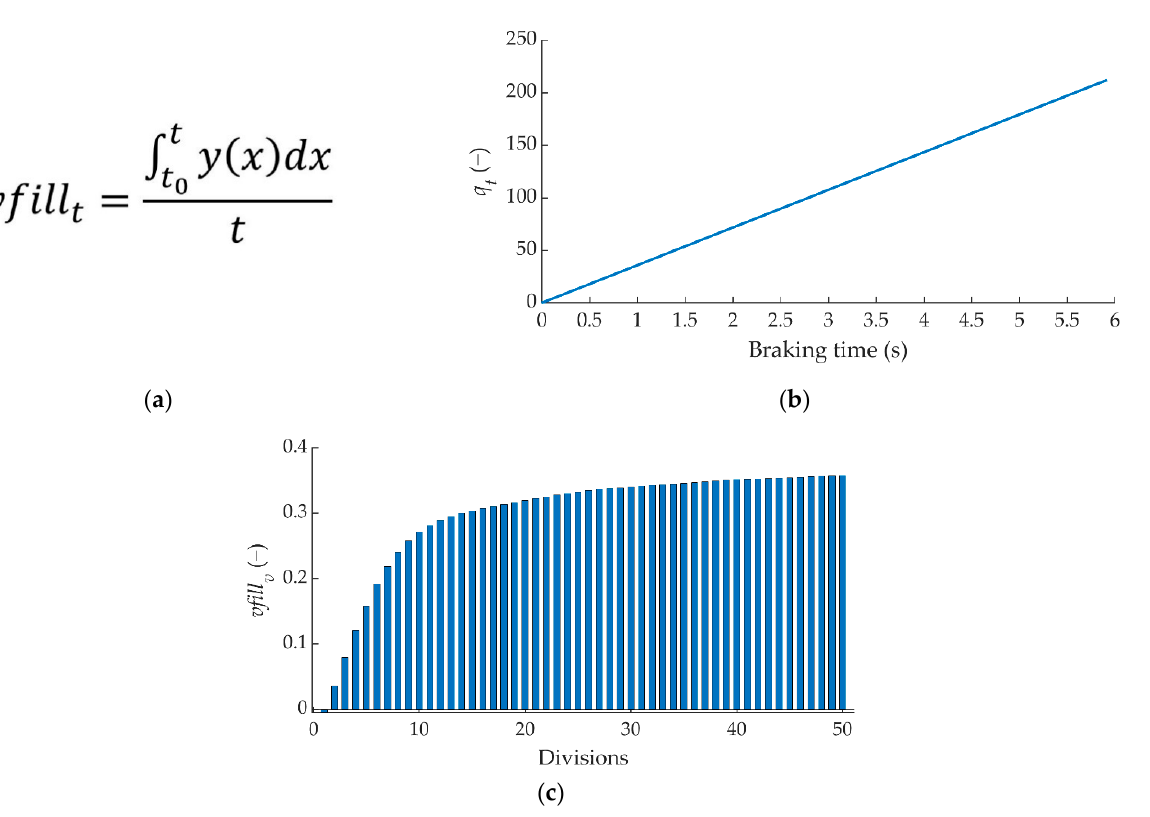
Figure 10. Methodology for the analysis of the data acquired by the pressure sensors to obtain ( a ) vfill t , ( b ) q t / t and ( c ) vfill v for 50 divisions.